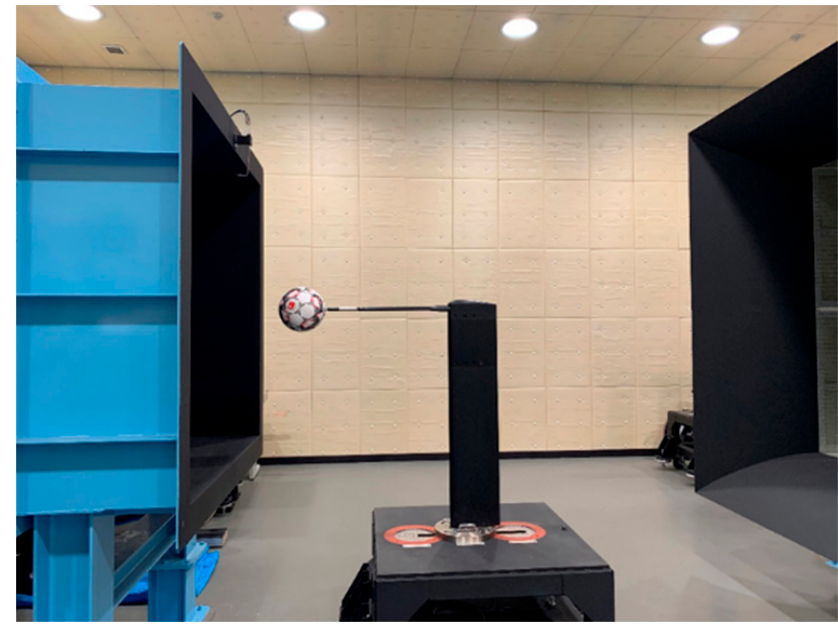
Figure 3. Wind tunnel test setup.